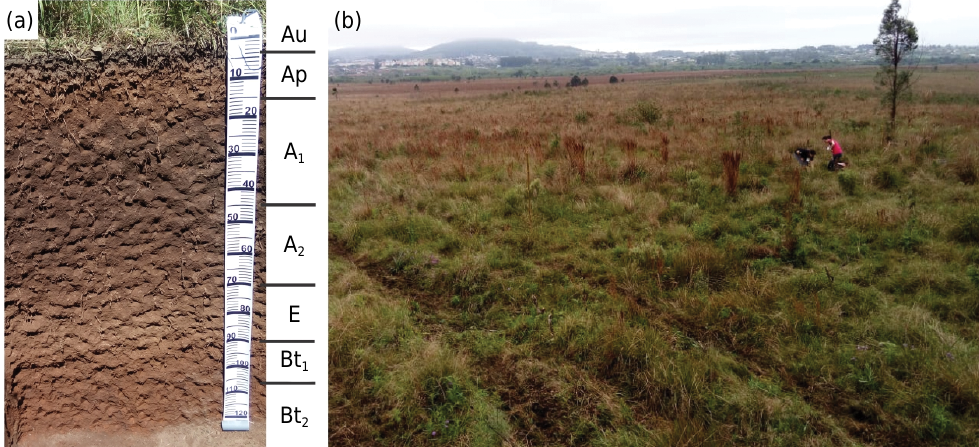
Figure 1. Soil profile (a) and landscape of experimental site (b) (Au: anthropogenic A horizon; Ap: agricultural A horizon; A: natural A horizon; E: eluvial horizon; Bt: textural B